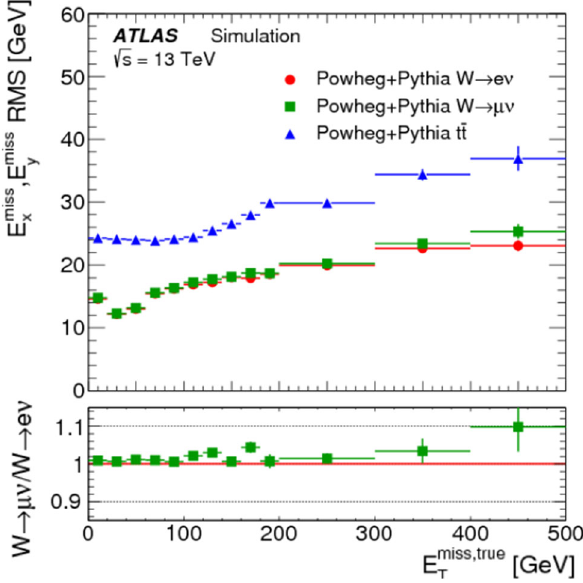
as a function of x ( y ) for the W → e ν , T